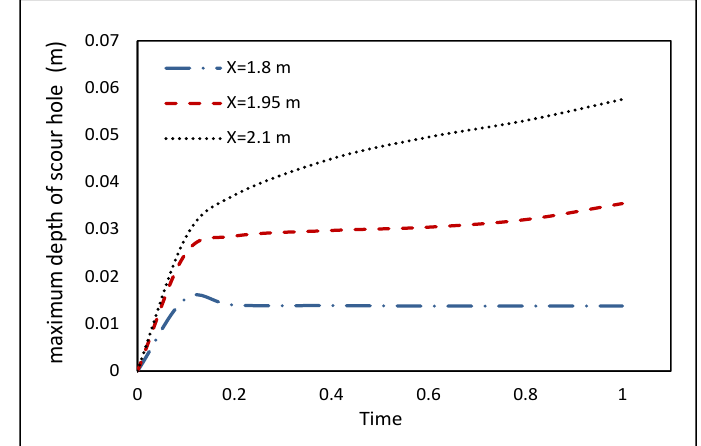
Figure 8. Comparison of maximum depth of the scour hole in upstream, downstream, and center points of the side